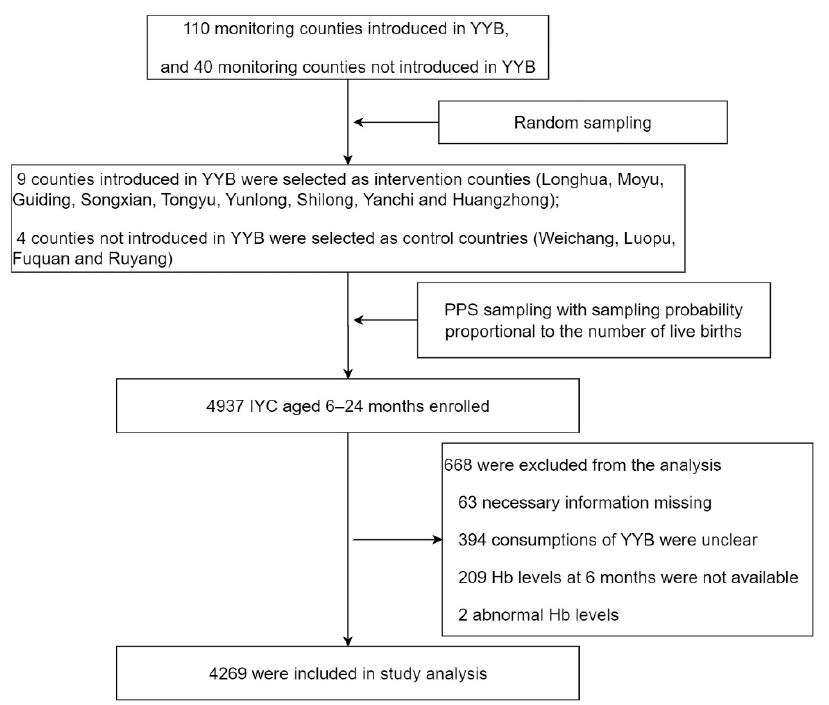
Figure 1. Flow chart. Inclusion and exclusion processes for subjects.